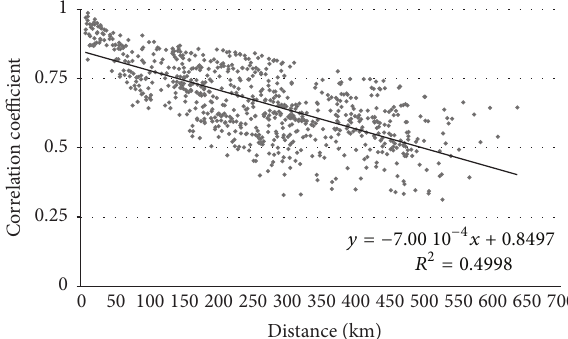
Figure 2: Mean monthly power load and the ratio of its minimal to maximal values of for a given year.